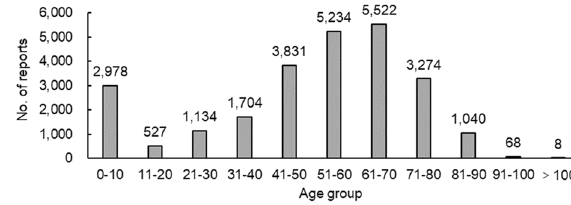
Figure 1. Number of reports in each age group.